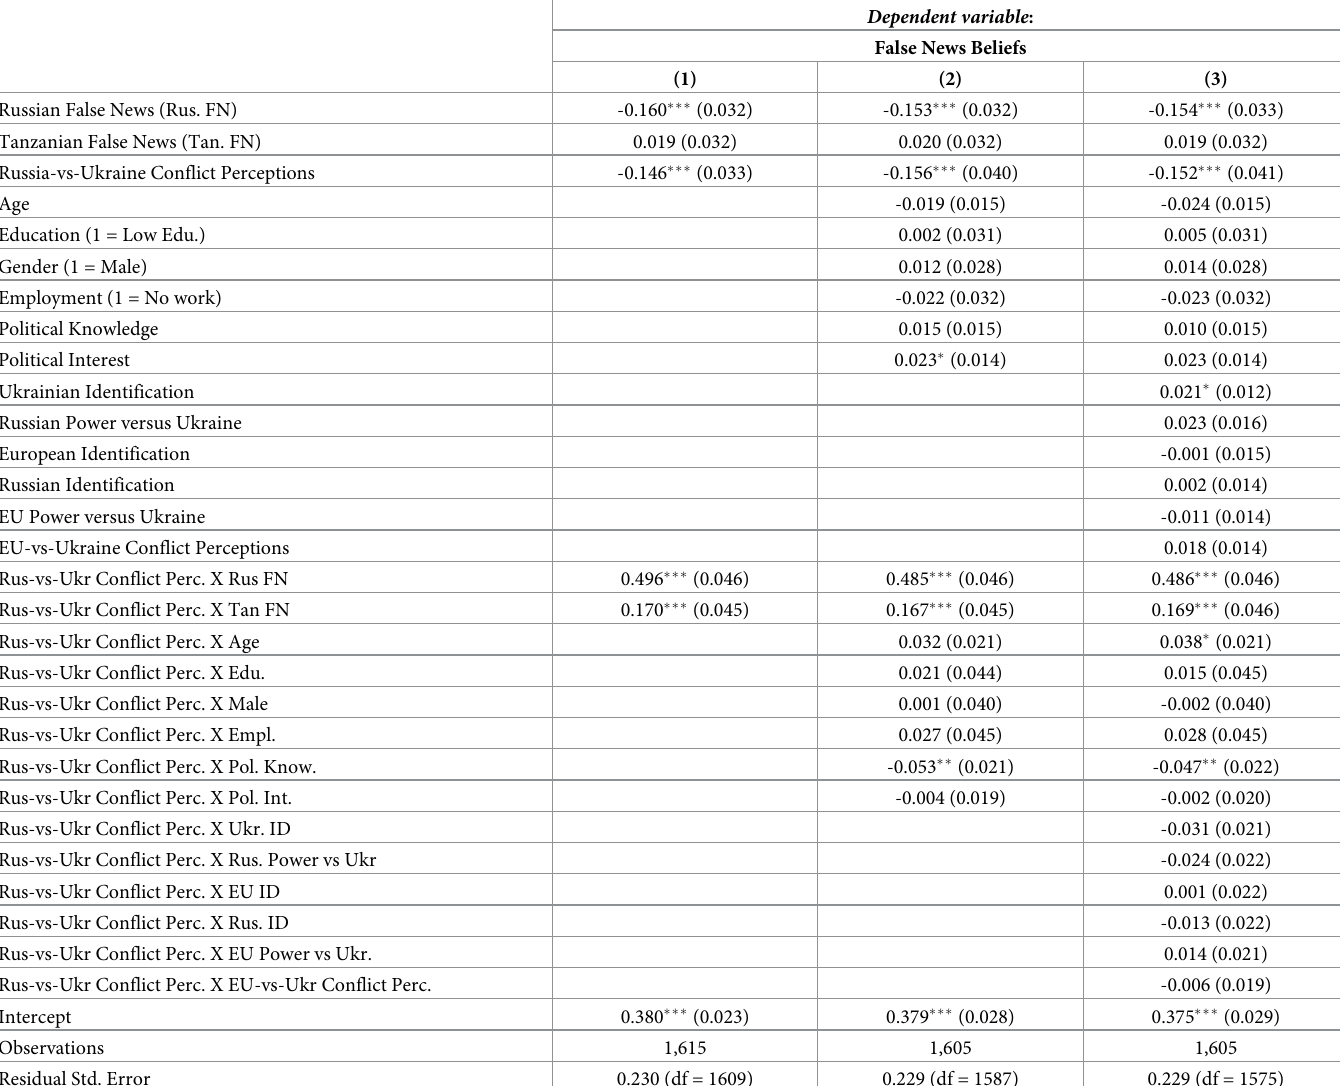
Table 2. Effect of treatment conditions and conflict perceptions on false news